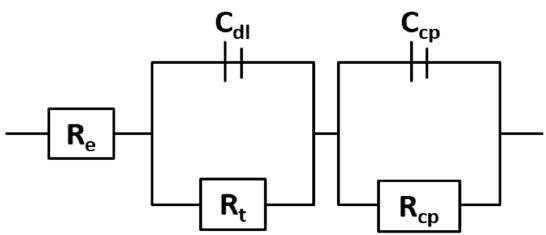
Figure 4. Equivalent circuit to which experimental data are fitted.